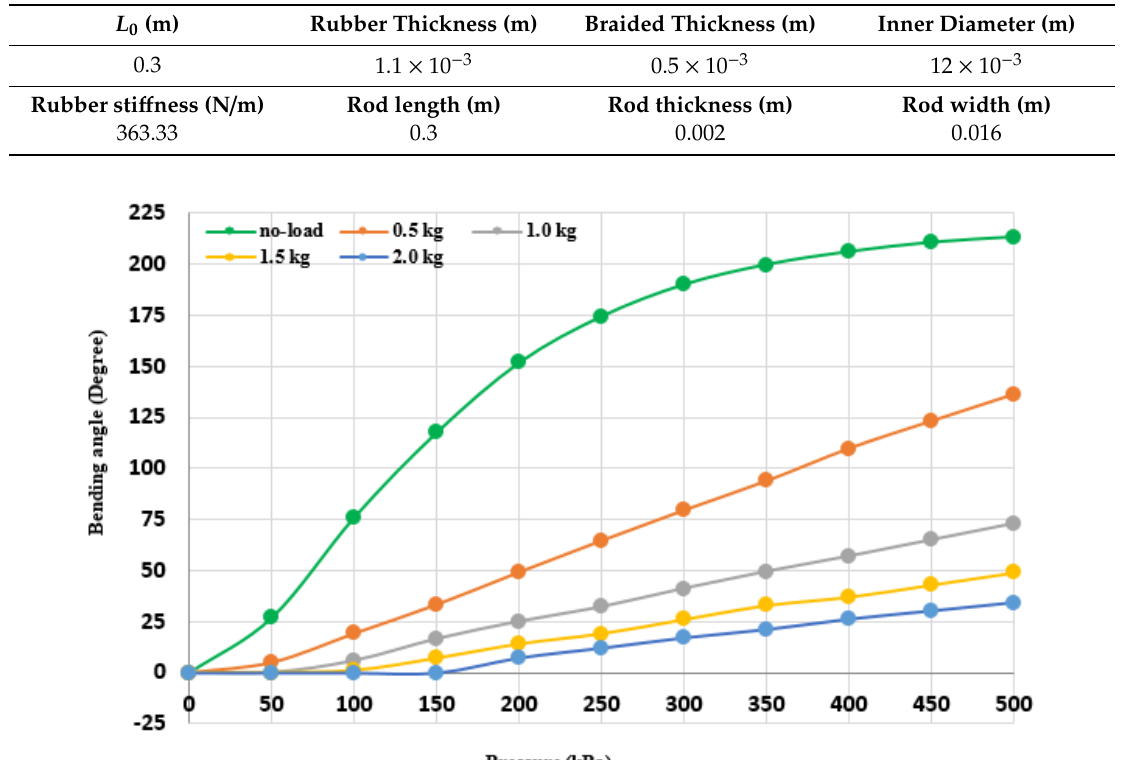
Figure 5. The bending angle at different attached loads for the 30 cm SBCA.